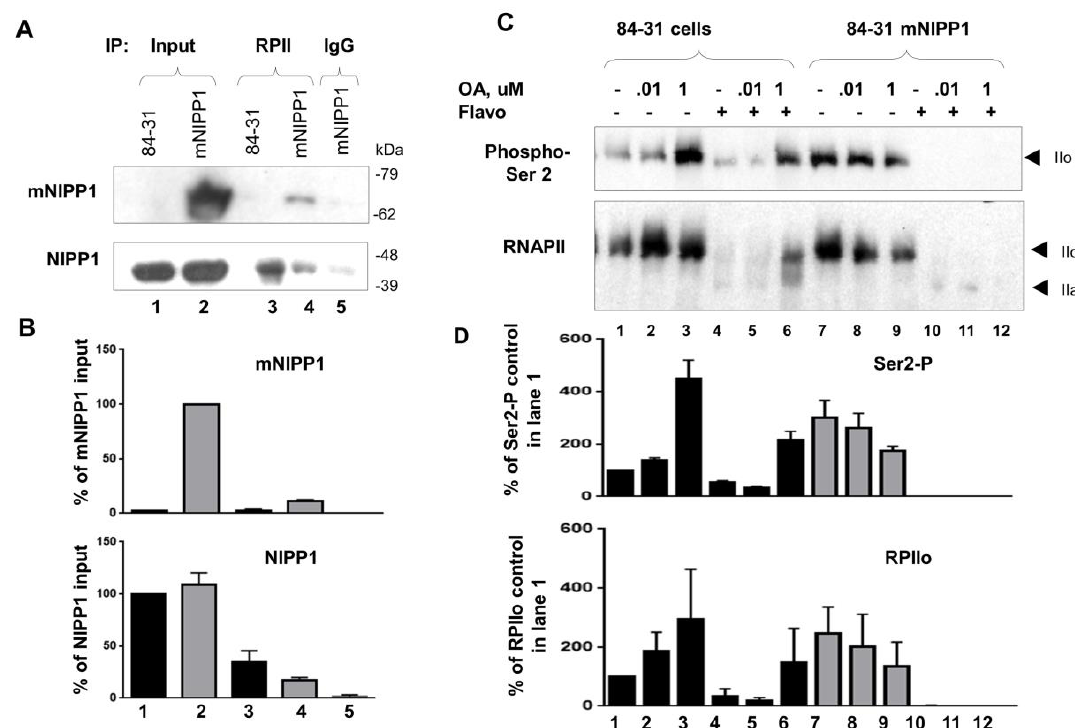
Figure 6. Stably expressed mNIPP1 associates with RNAPII and increases its phosphorylation. ( A , B ) mNIPP1 co-precipitates with RNAPII. RNAPII was immunoprecipitated from 84-21 cell extract with 8WG16 monoclonal antibodies. Immunoprecipitated proteins were resolved by 7.5% SDS-PAGE and immunoblotted with anti-NIPP1 antibodies. Panel B shows quantification of the panel A; ( C , D ) Expression of mNIPP1 alters the phosphorylation of RNAPII CTD. 84-31 cells or 84-31-mNIPP1 cells were treated where indicated with 25 μM flavopiridol for 30 min to promote RNAPII dephosphorylation. The cell were also treated for 30 min with 0.1 μM or 1 μM okadaic acid (OA) prior to the treatment with flavopiridol, to block PP2A or PP1 phosphatases. Whole cell lysates were prepared, resolved on 5% SDS-PAGE and analyzed by Western blot with Ser-2 phospho-epitope specific antibodies (upper panel) or RNAPII-specific antibodies (lower panel). The hyperphosphorylated (IIo) and hypophosphorylated (IIa) forms of RNAPII are indicated. Panel D shows quantification of panel C.